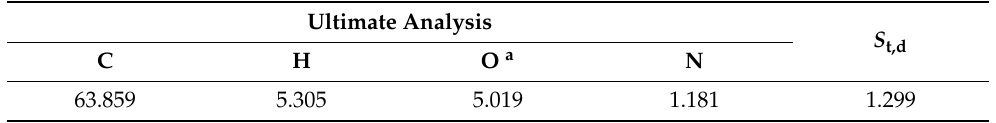
Table 1. Elemental content analysis of waste tires